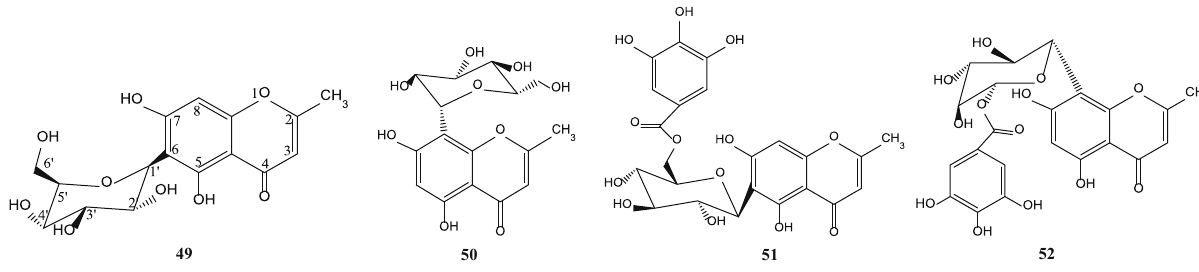
Figure 3: Chromone glycosides from various parts of S.